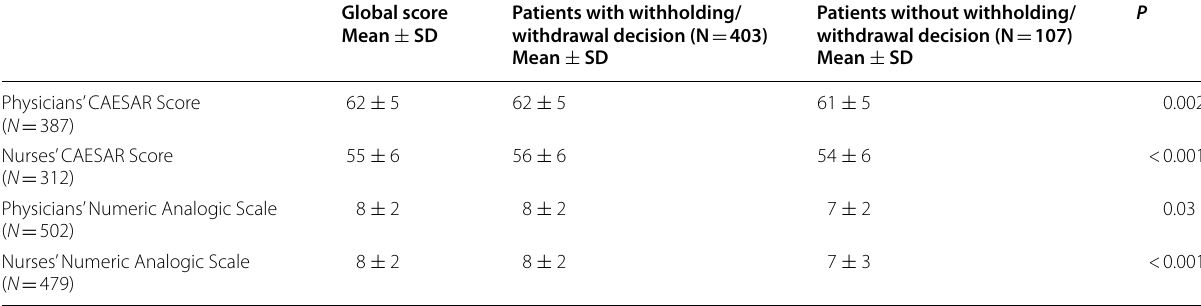
Table 4 CAESAR score and Numeric Analogic Score